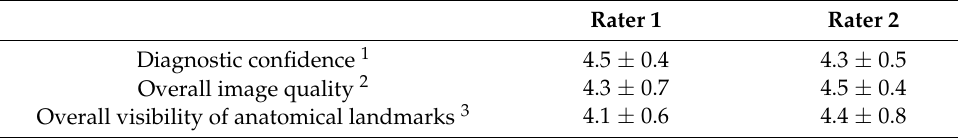
Table 3. Mean diagnostic confidence, image quality and visibility.